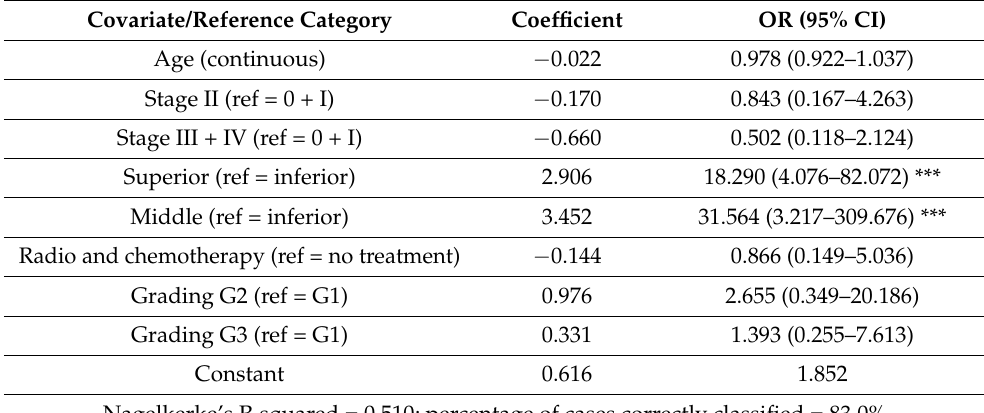
Table 3. Odd ratios of AF vs. A in the sample of patients with complications. Covariate/Reference Category Coefficient OR (95%